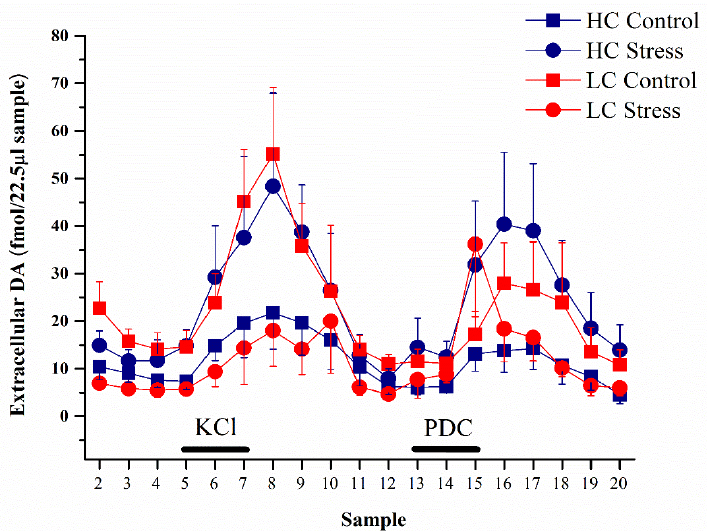
Figure 3. Extracellular dopamine levels in the NAc shell as measured during microdialysis (aver- age + or-SEM). Baseline (samples 2–4), perfusion with 50 mM KCl solution (samples 5–7), and per- fusion with 4 mM l-trans-pyrrolidine-2,4-dicarboxylate (PDC) (samples 13–15). HC-controls, n = 8; HC-stress, n = 8; LC-controls, n = 7; and LC-stress, n = 6. HC, high 50-kHz USV rats and LC, low 50-kHz USV rats. = 7) and LC-stress, 6.1 ± 0.9 fmol/22.5 μL sample ( n = 6). LC-controls had higher baseline